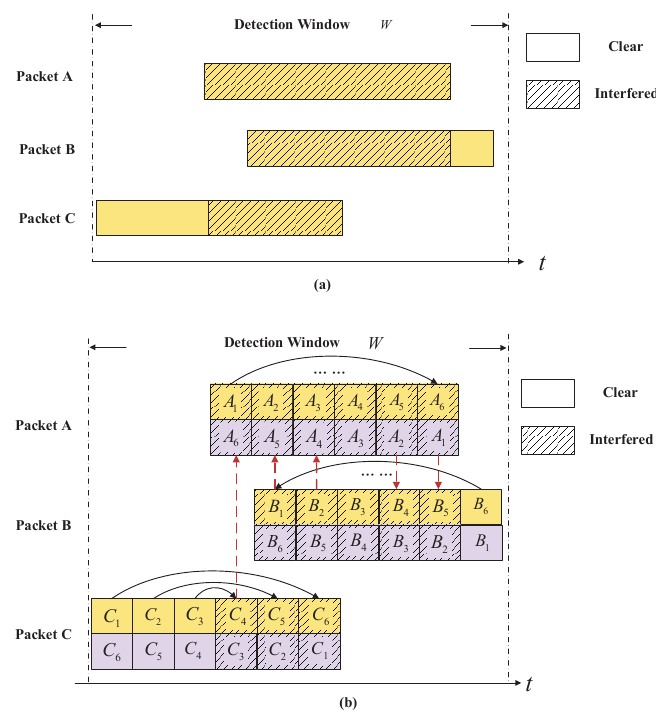
Figure 2. Codebook collision resolution in AF-SCMA. Different colors of packets represent the packets encoded with different codebooks. ( a ) Codebook collisions. ( b ) SIC procedure in